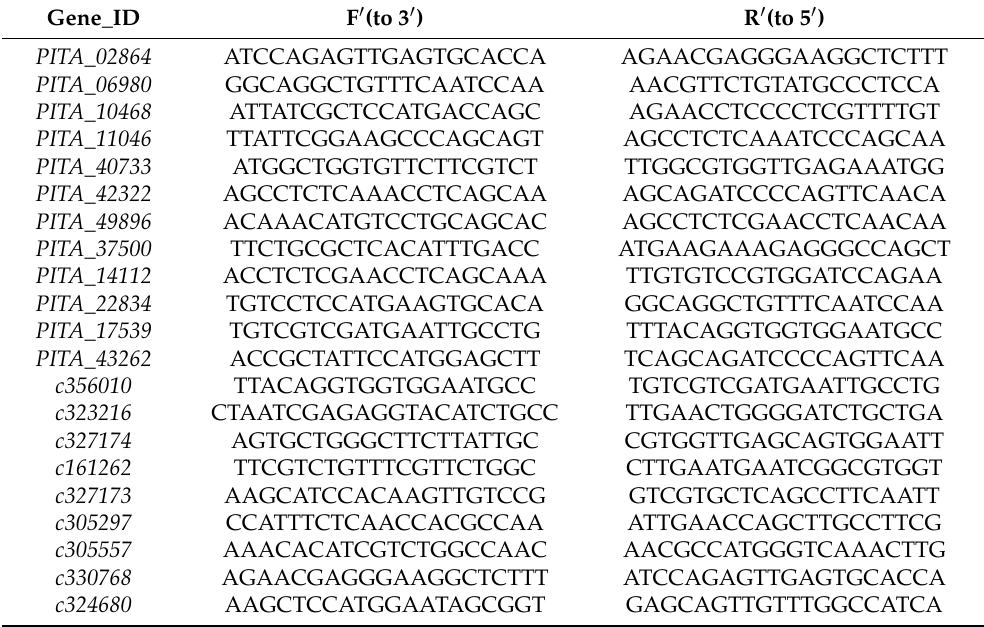
Table A2. Primers used for